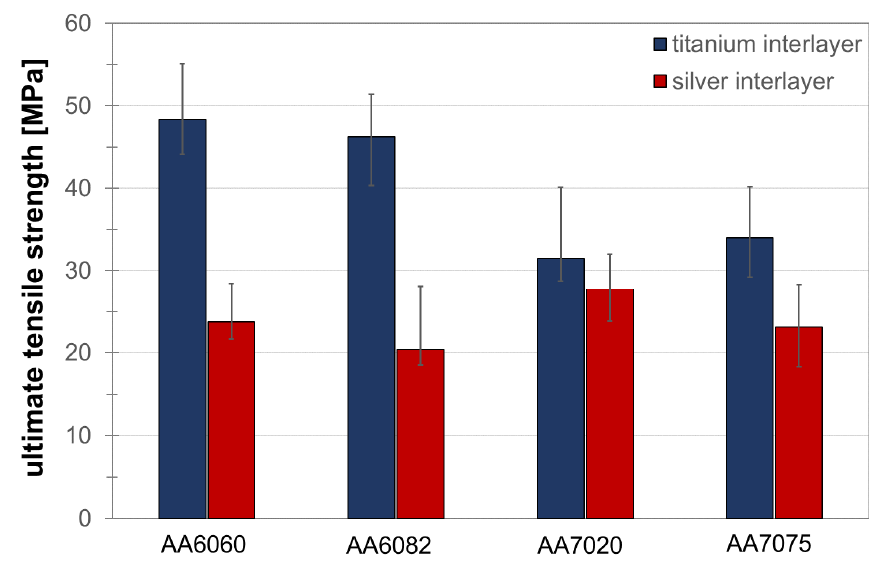
Figure 10. Joint strength of diffusion-bonded aluminum and magnesium with titanium or silver interlayers.